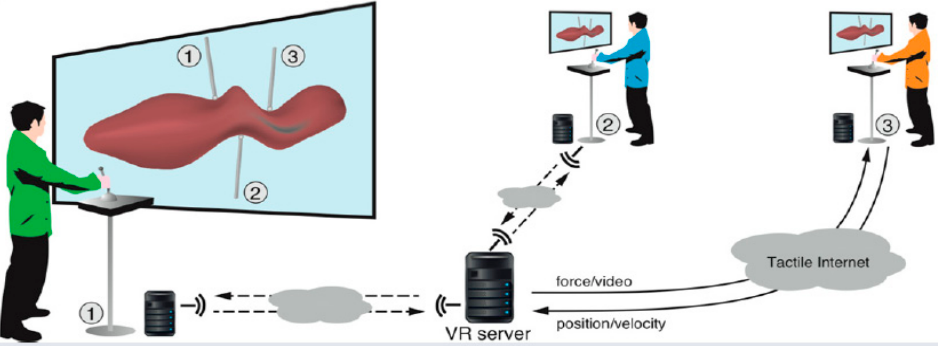
Figure 12. Physical coupling of several users via VR simulation with haptic feedback [13].